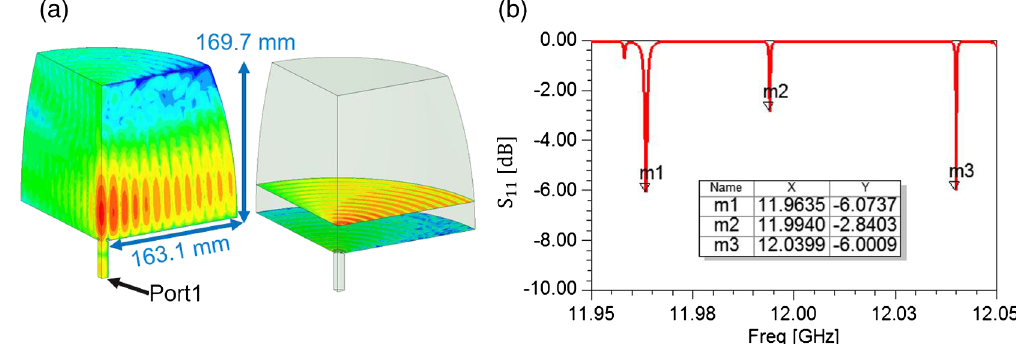
FIG. 13. (a) Electrical field of one quarter model of storage cavity. One quarter model was simulated by frequency domain solver of HFSS. The electrical field is in logarithmic scale. (b) S 11 frequency sweep of the storage cavity.